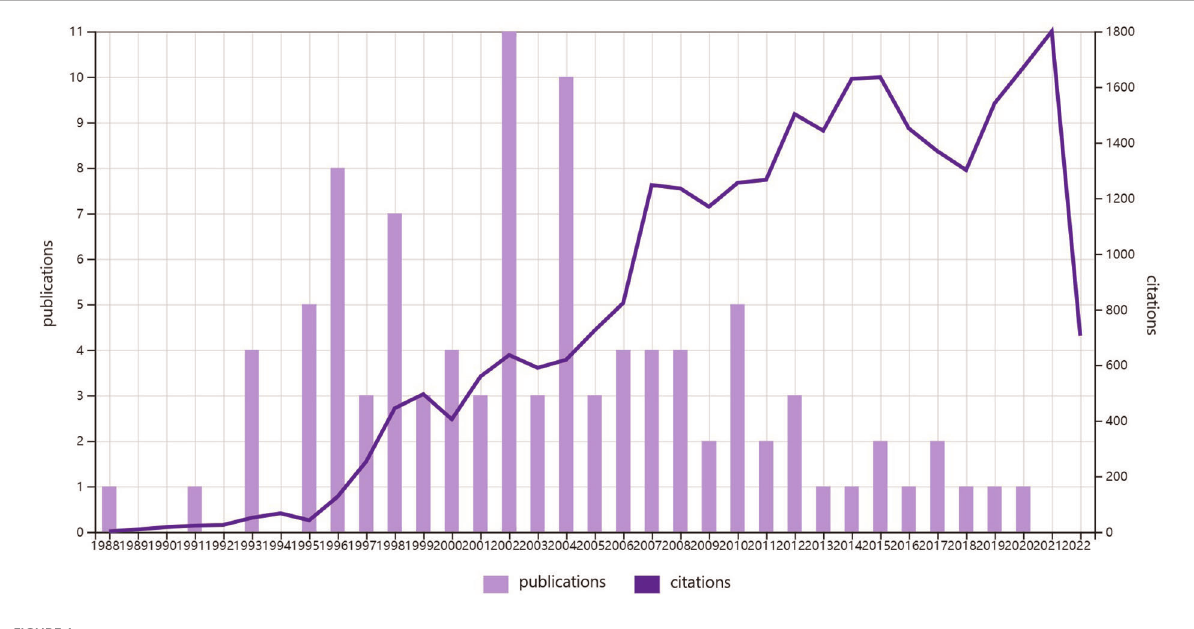
FIGURE 1 The publication time and citation distribution of the T100 articles in